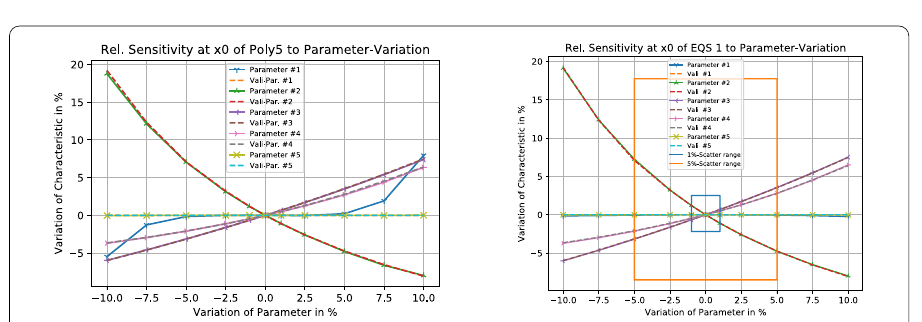
Fig. 28 Plate rel. sensitivity for fifth order polynomial and third/third exponential degree